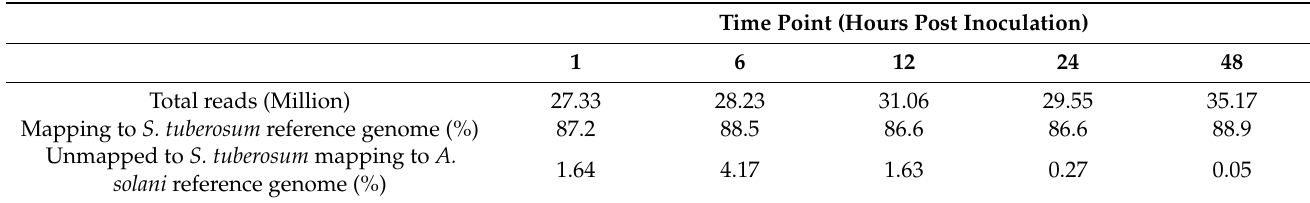
Table 1. Transcriptome statistics of S. tuberosum and A. solani during infection. Total reads (million), percentage of reads mapping to potato reference genome and percentage of reads unmapped to potato genome mapping to A. solani reference genome for all A. solani inoculated samples per time point, average of biological replicates given. Time Point (Hours Post